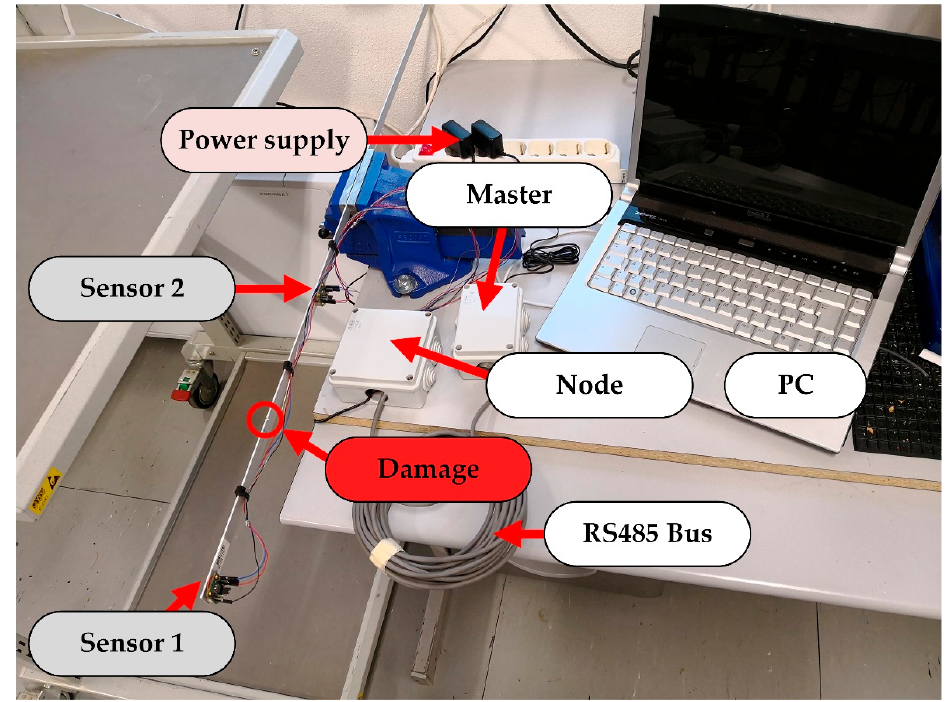
Figure 4. Experimental set-up of testing structure for the identification of the damage indicator.